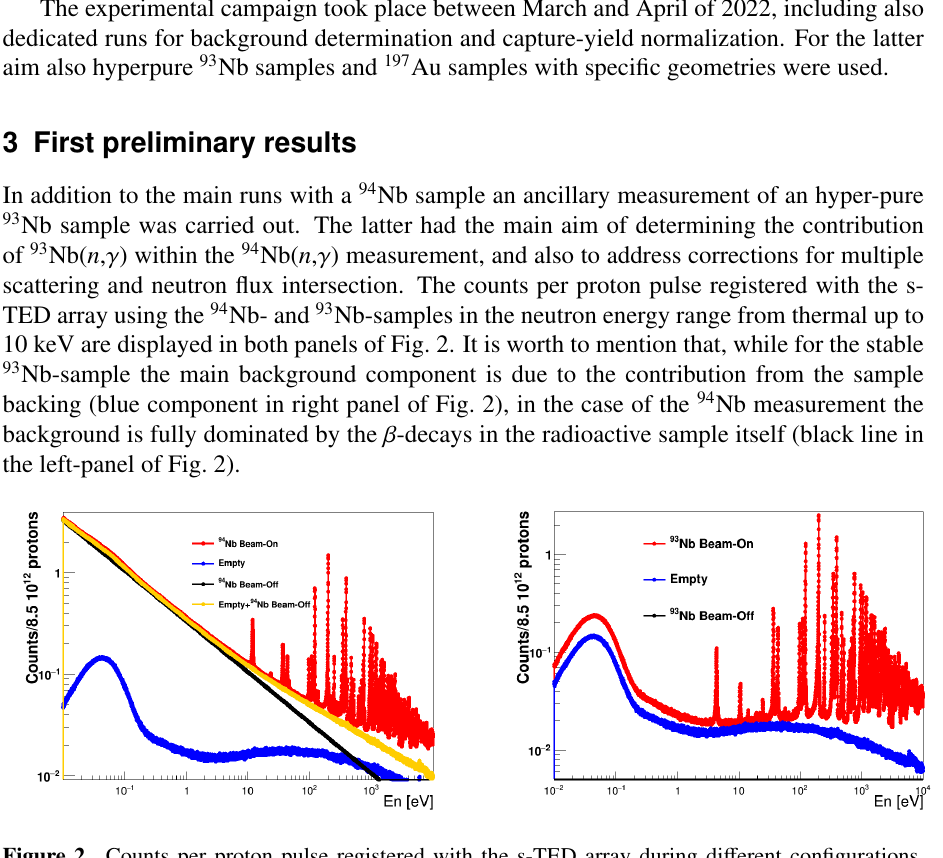
Figure 2. Counts per proton pulse registered with the s-TED array during di ff erent configurations. The left panel shows the results for the 94 Nb-sample measurement, whereas the pure 93Nb sample measurement is shown on the right